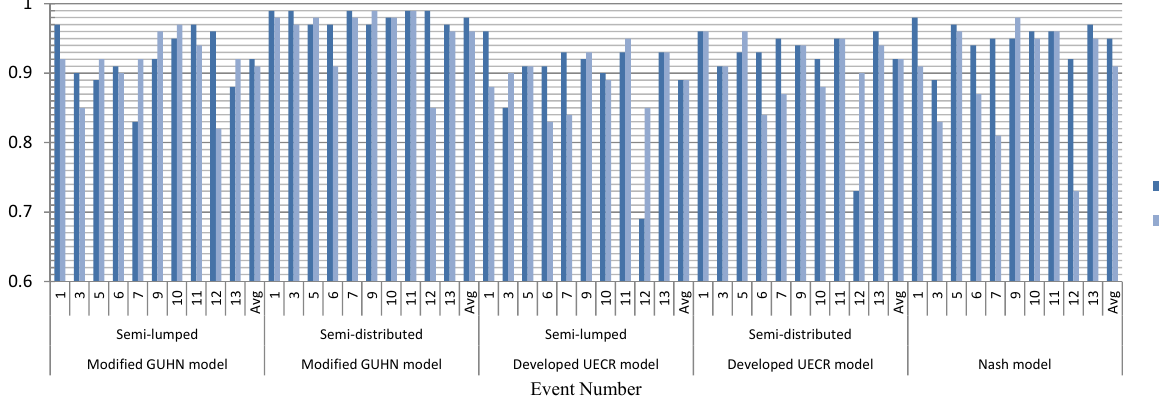
Figure 9. Calibration